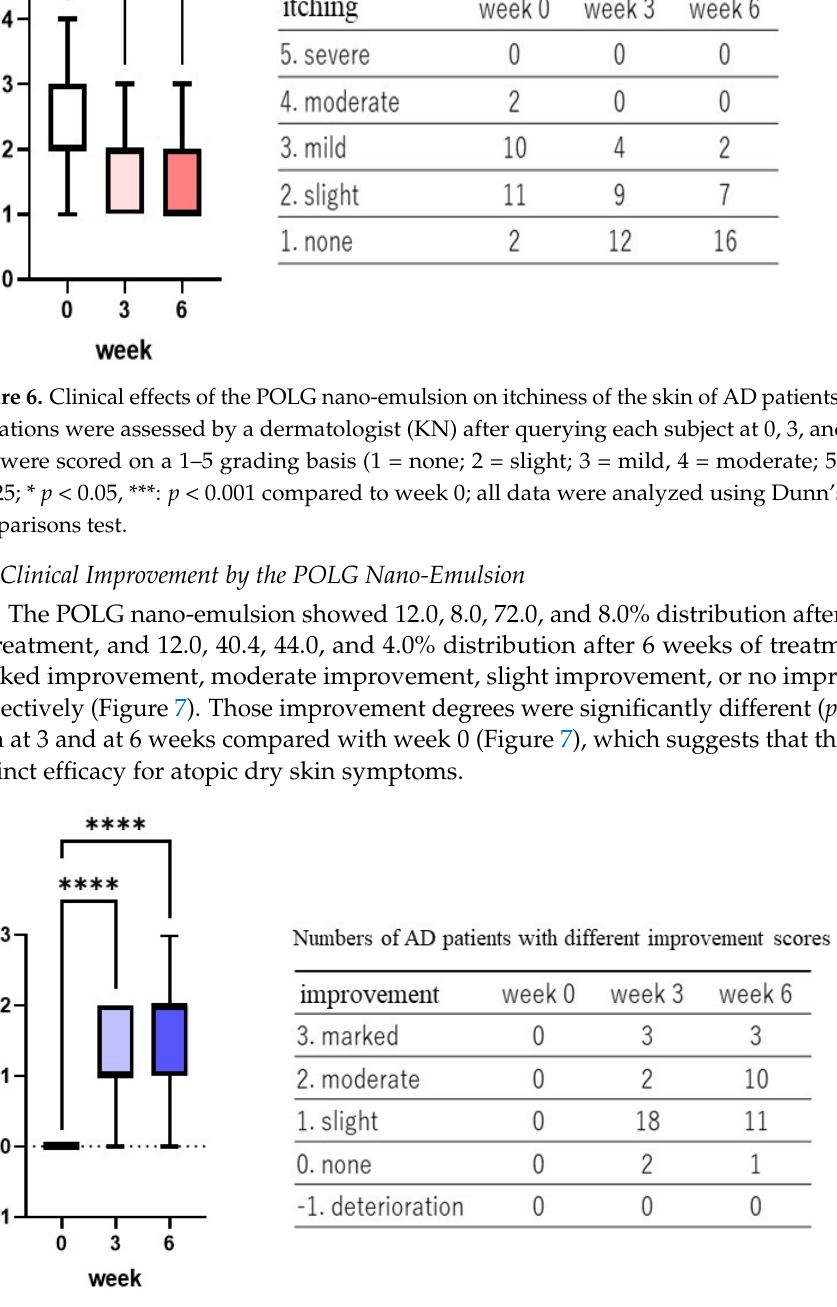
Figure 7. Clinical improvement of the POLG nano-emulsion on AD skin. Clinical improvement was assessed by a dermatologist (KN) at 3 and at 6 weeks after comprehensively evaluating the clinical scoring, n, and was scored on a 0–3 grading basis (3 = marked improvement, 2 = moderate improvement, 1 = slight improvement, 0 = no improvement), as described in the Materials and Methods section. n = 25; ****: p < 0.0001 compared to week 0; all data were analyzed using Dunn’s multiple comparisons